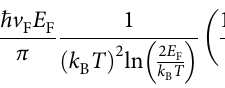
Fig. 2b. The crossover between the far- and close-gate regimes